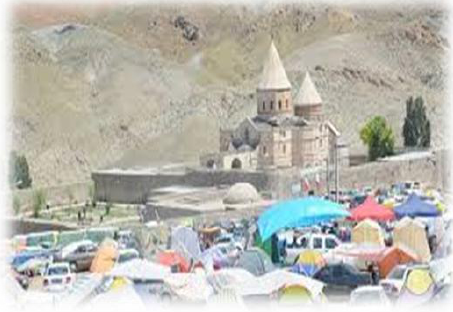
Figure 3. Religious ceremony of Armenian